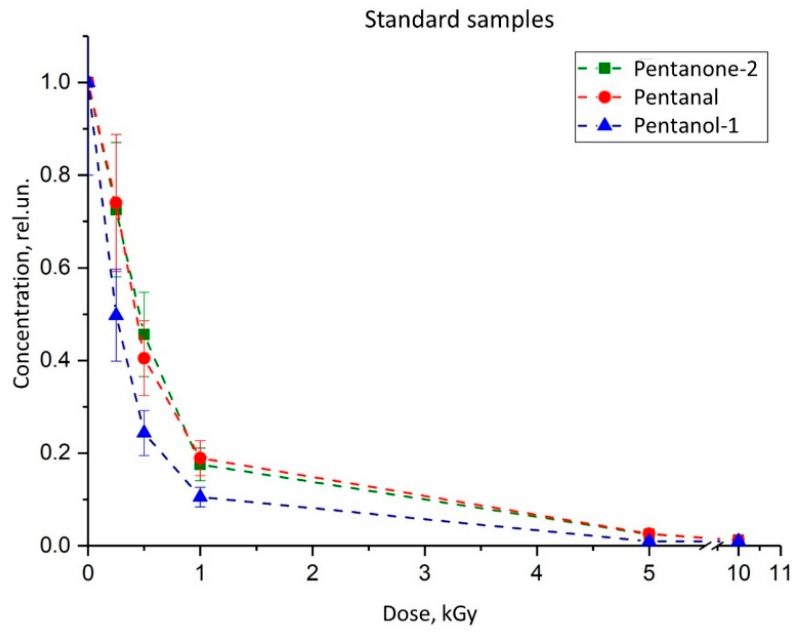
Figure 1. The dependencies of the concentrations of Pentanone-2, Pentanal, and Pentanol-1 in saline solution on the irradiation dose.